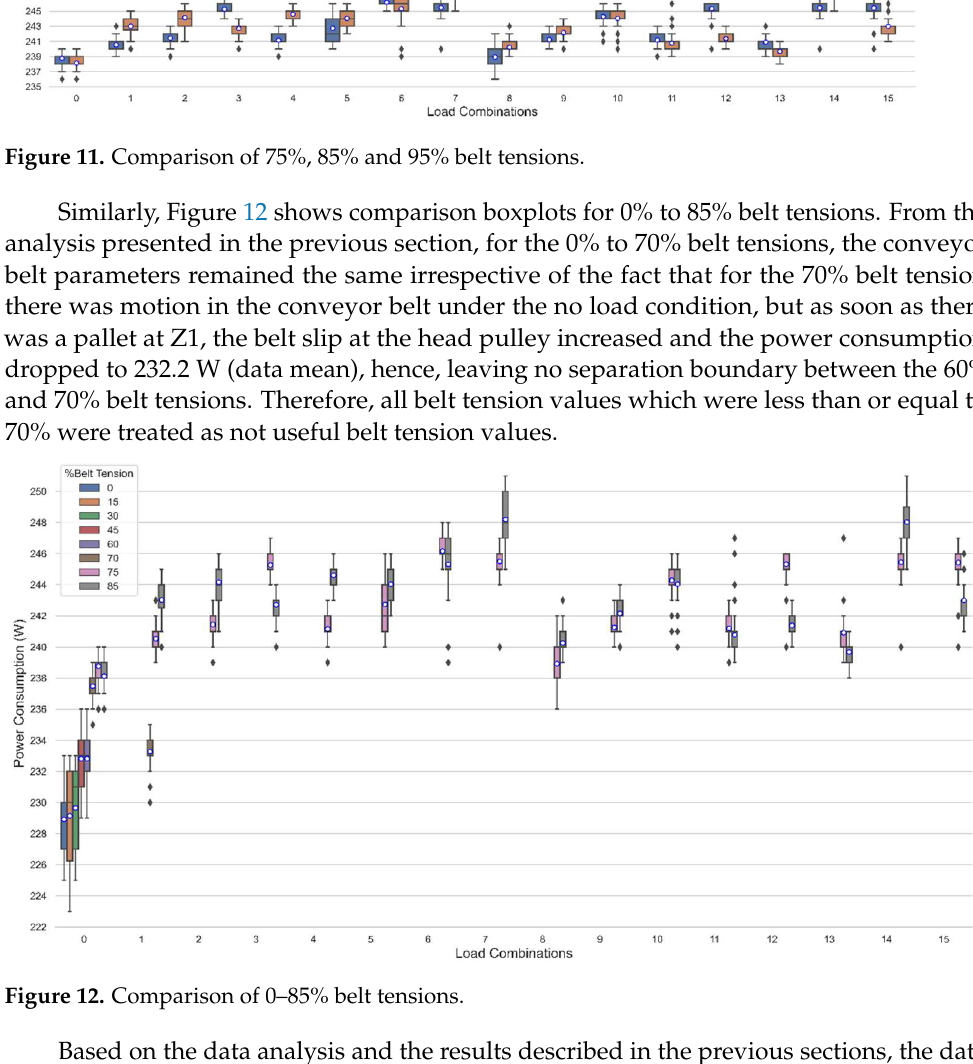
Figure 11. Comparison of 75%, 85% and 95% belt tensions.